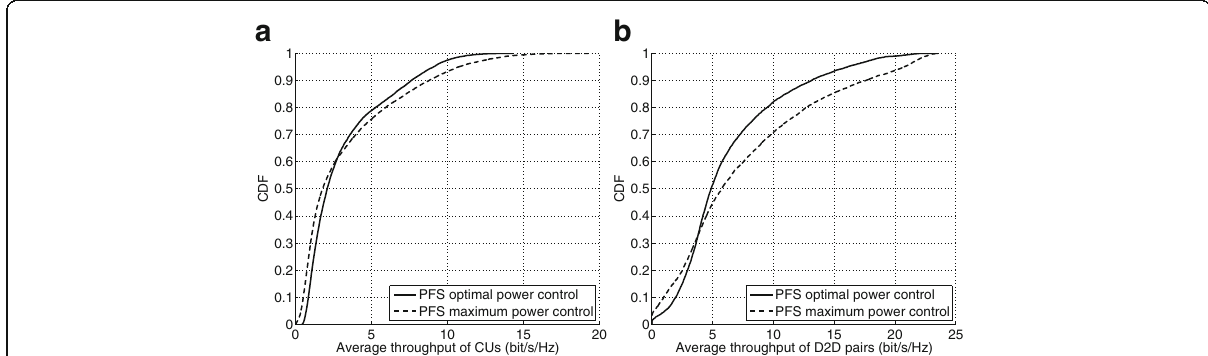
Fig. 7 The CDF of average throughput of PFS with different power control methods. a CUs. b D2D